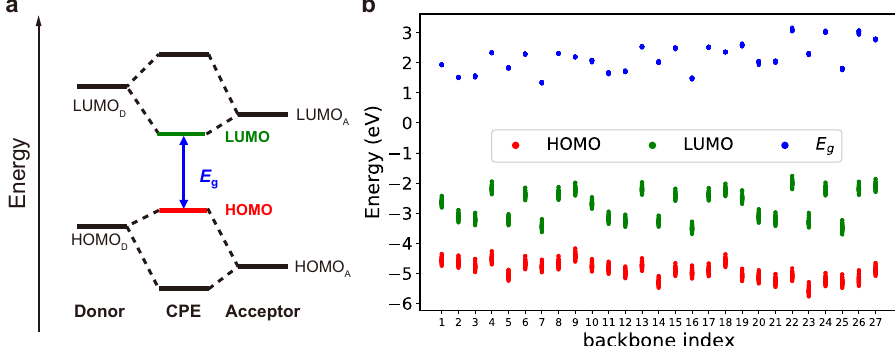
Fig. 2 Schematic diagram and results for HOMO, LUMO and E g . a Illustration of LUMO/HOMO levels and E g of a CPE; the HOMO/LUMO levels of its corresponding donor (HOMO D /LUMO D ) and acceptor (HOMO A /LUMO A ) units are also shown. b Summary of HOMO, LUMO levels, and E g calculated with PBE functional as a function of the backbone index for 1296 anionic